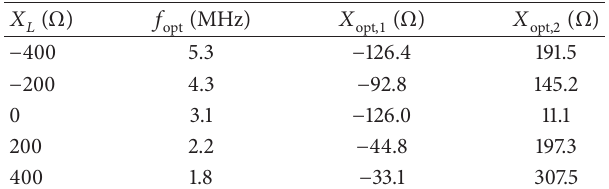
Figure 9: Adaptive impedance-matching circuit. Table 3: Optimal frequencies and values of the compensating components. (The load resistance 𝑅 𝐿 is fixed at 50 Ω .)